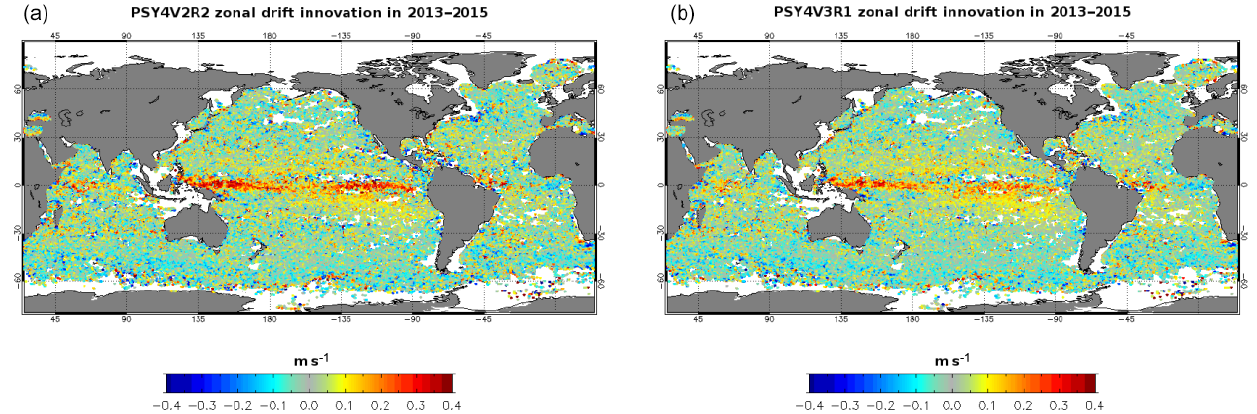
Figure 29. Mean zonal drift innovation (ms − 1 ) with PSY4V2 (a) and PSY4V3 (b) over the time period 2013–2015. Observations come from Argo surface floats and a surface-drifter-corrected dataset (Rio, 2012). Units are ms − 1